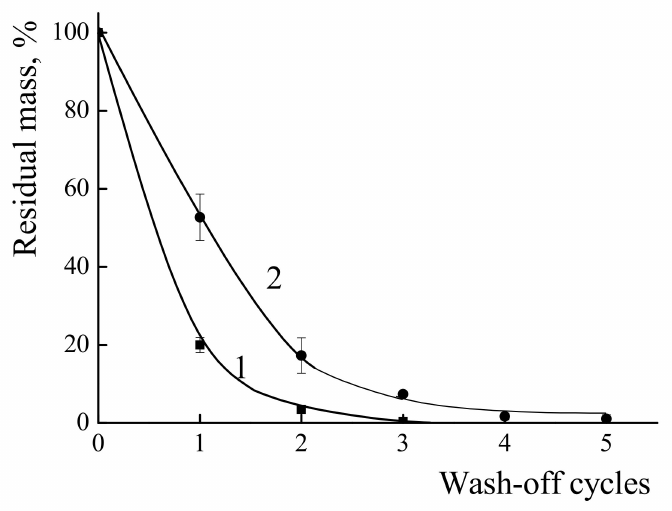
Figure 7. Dependence of the percentage of the preserved mass of films formed from PDADMAC (1) and IPEC (2) on a PVC surface on the number of wash-off